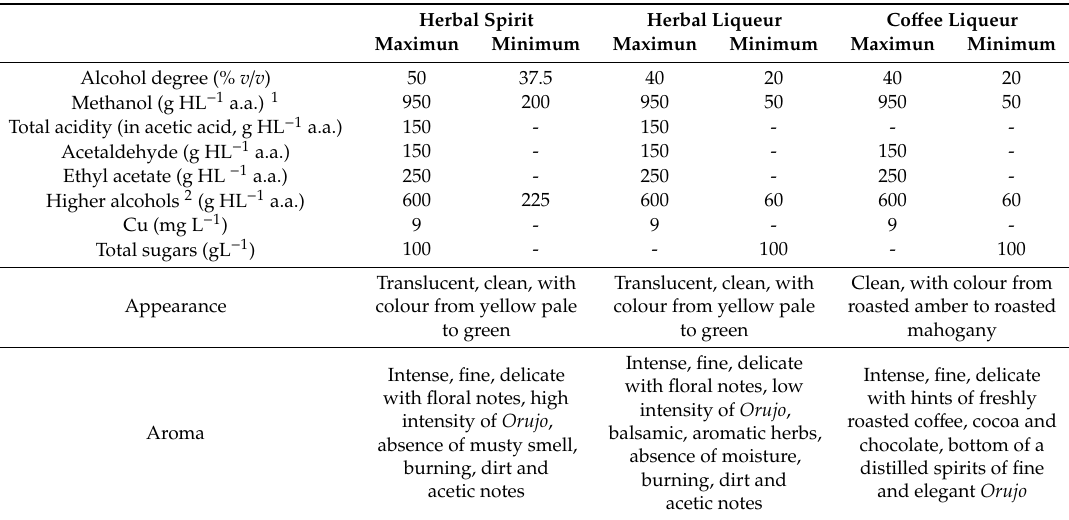
Table A1. Quality control requirements (chemical and sensorial) established for the three types of beverages, according to the Regulating Council